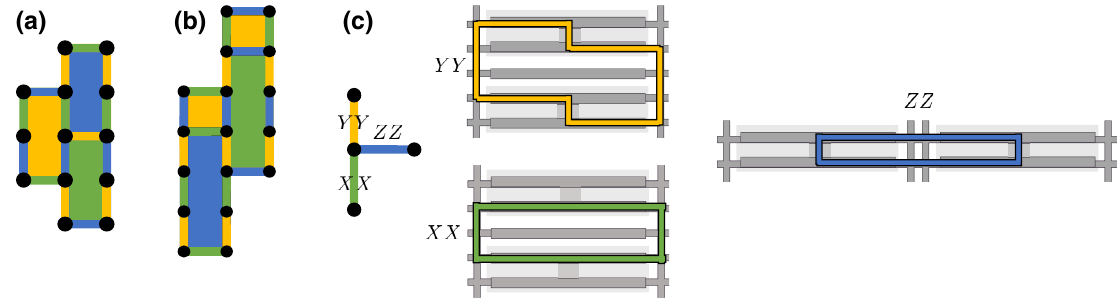
FIG. 4. (a) The vertical brick-wall unit of the honeycomb lattice. (b) The vertical brick-wall unit of the 4.8.8 lattice. (c) The bulk- measurement loops. The colors refer to the measurement time steps, rather than the Pauli